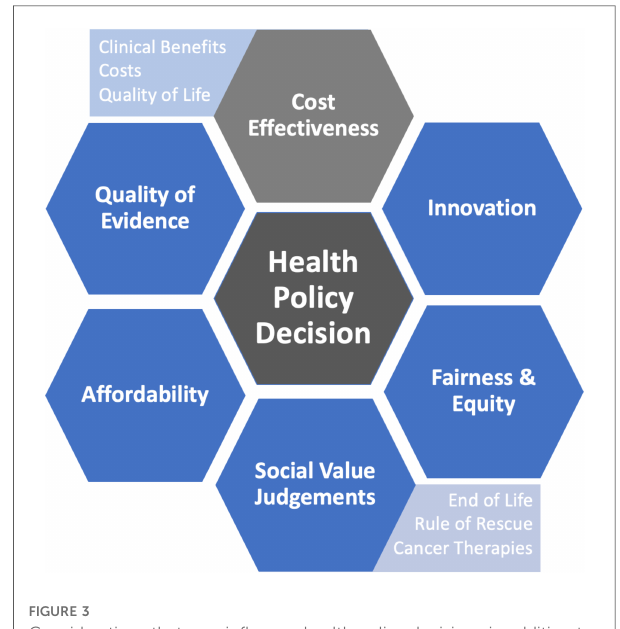
FIGURE 3 Considerations that may in fl uence health policy decisions in addition to